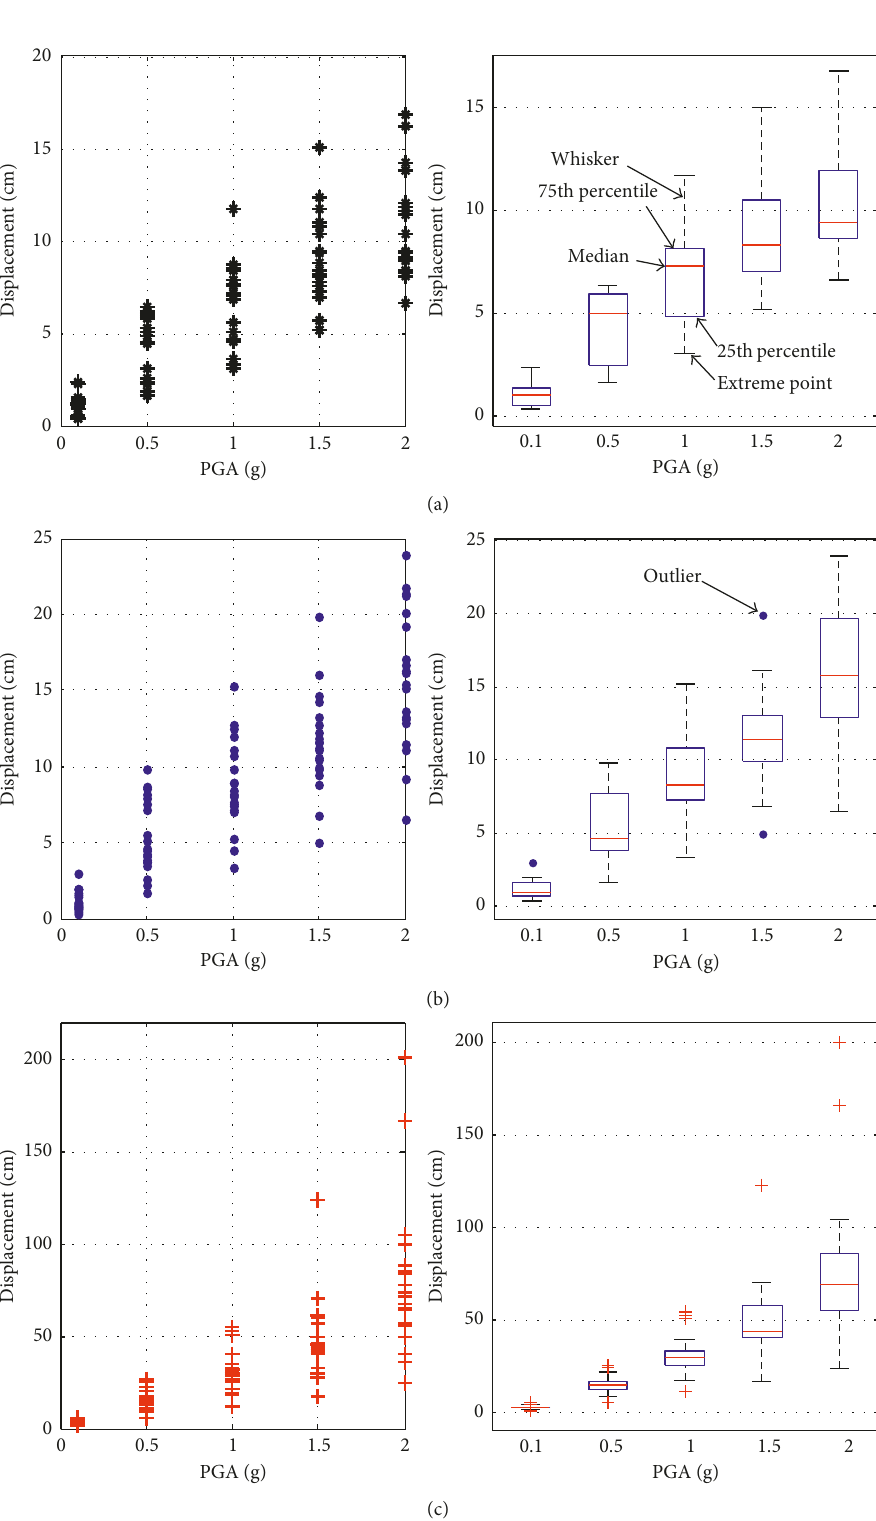
Figure 8: Maximum top displacement of the NPP containment building for three soil conditions under 20 earthquake ground motions normalized to PGA of 0.1g–2g: (a) no SSI; (b) hard soil; (c) soft